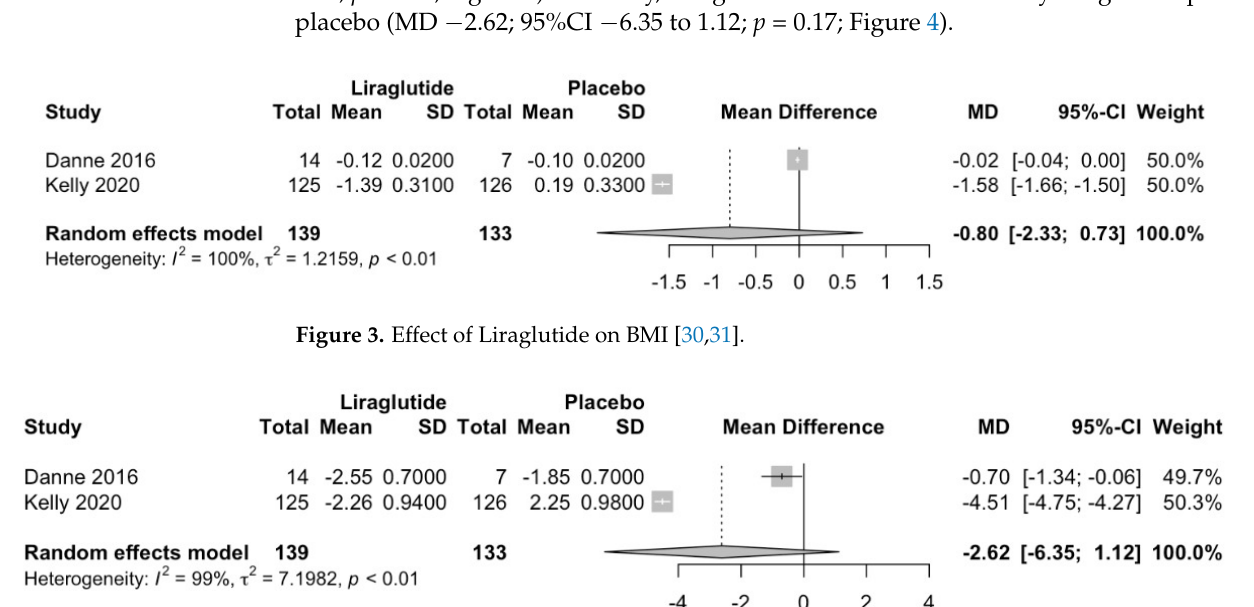
Figure 2. Results of the risk of bias analysis for the included RCTs [5,30,31].